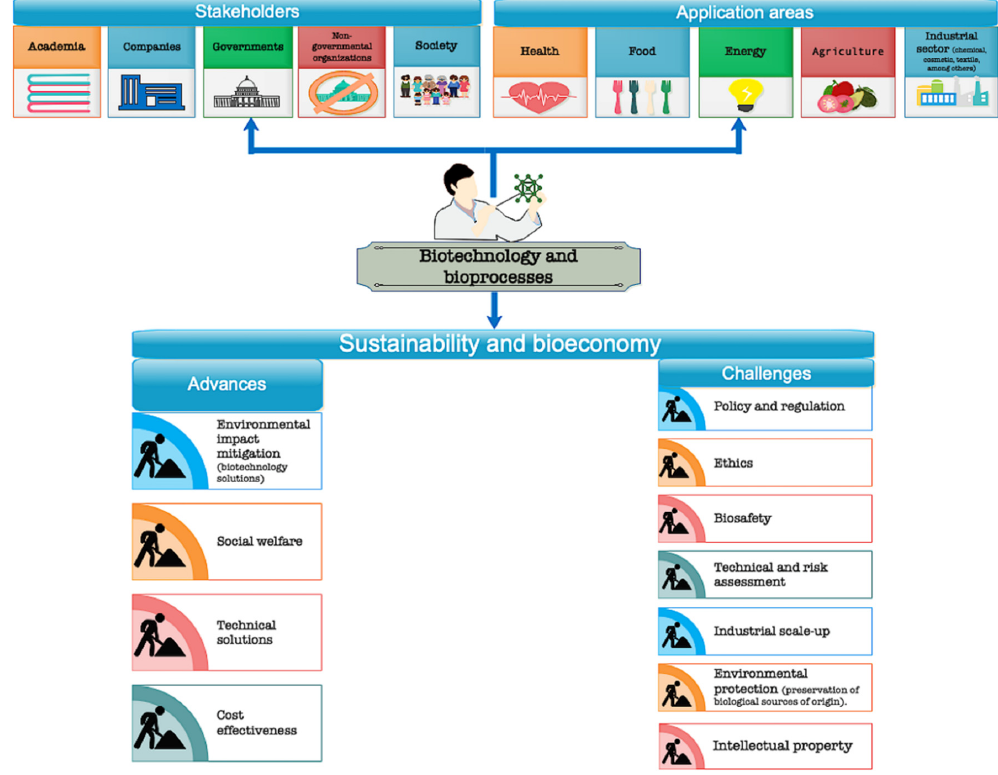
Figure 1. Bioeconomy, biotechnology, and sustainability. Source: elaborated by the authors.